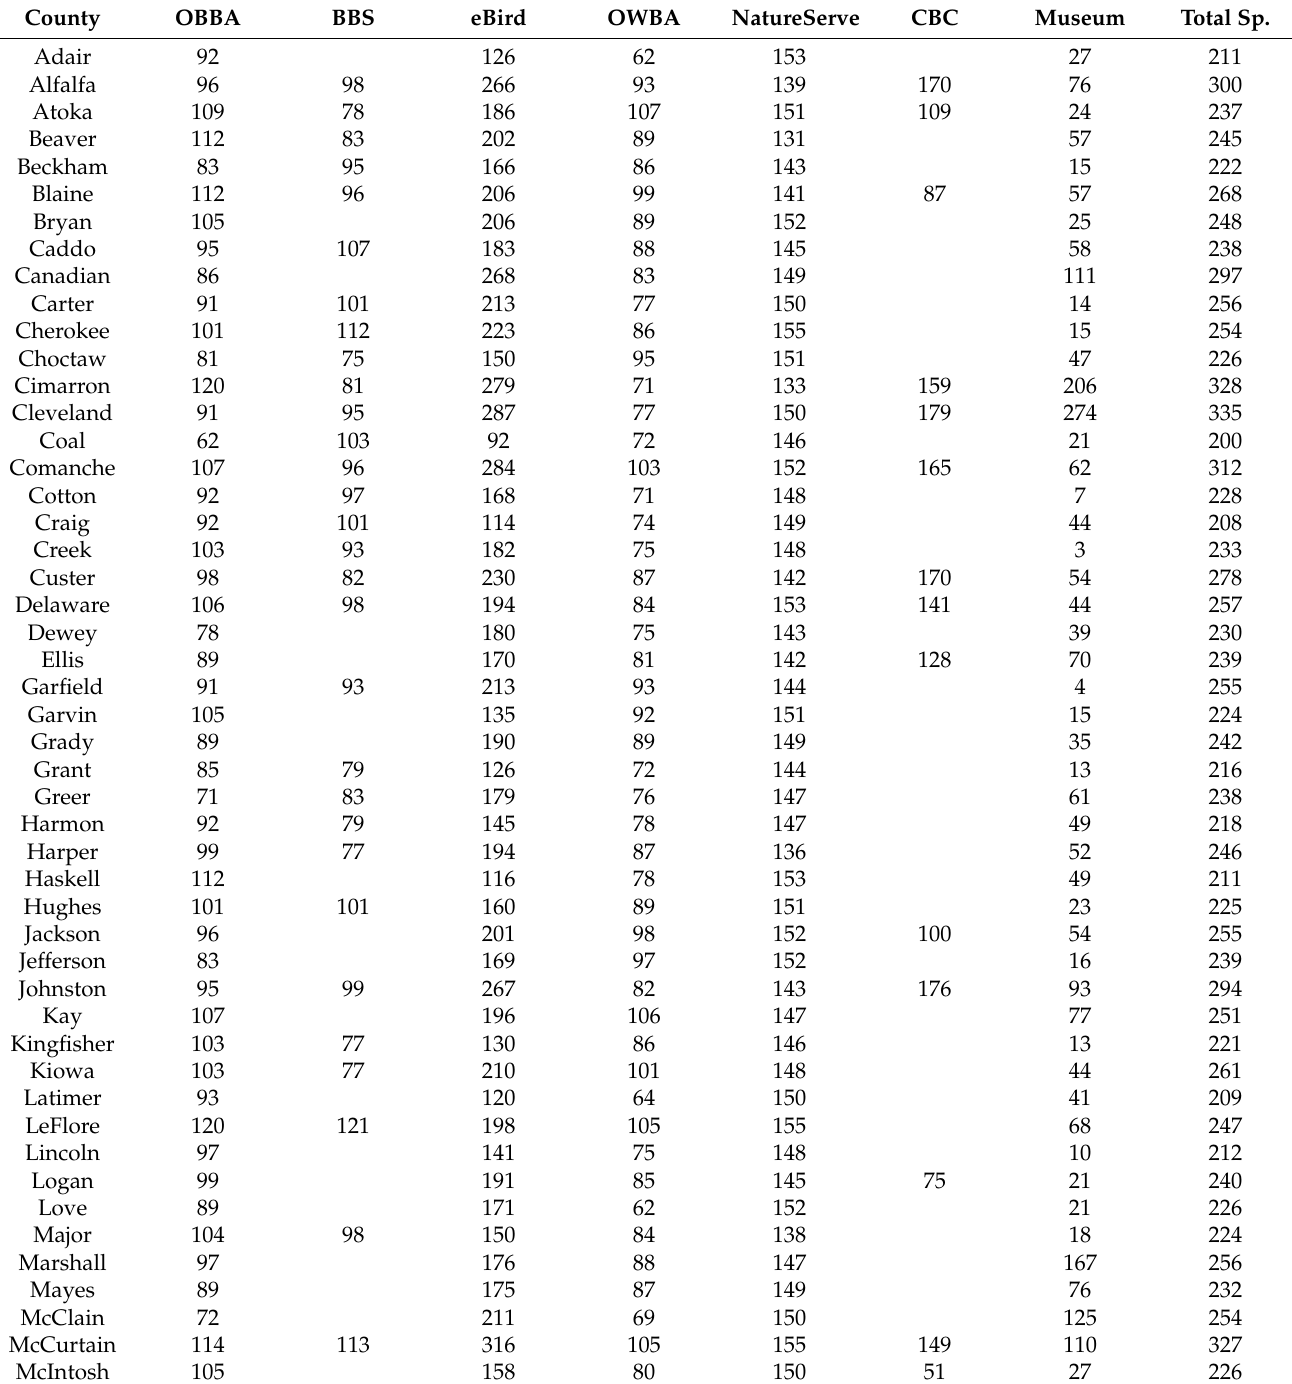
Table 2. Total number of species recorded by each method for the 77 counties in